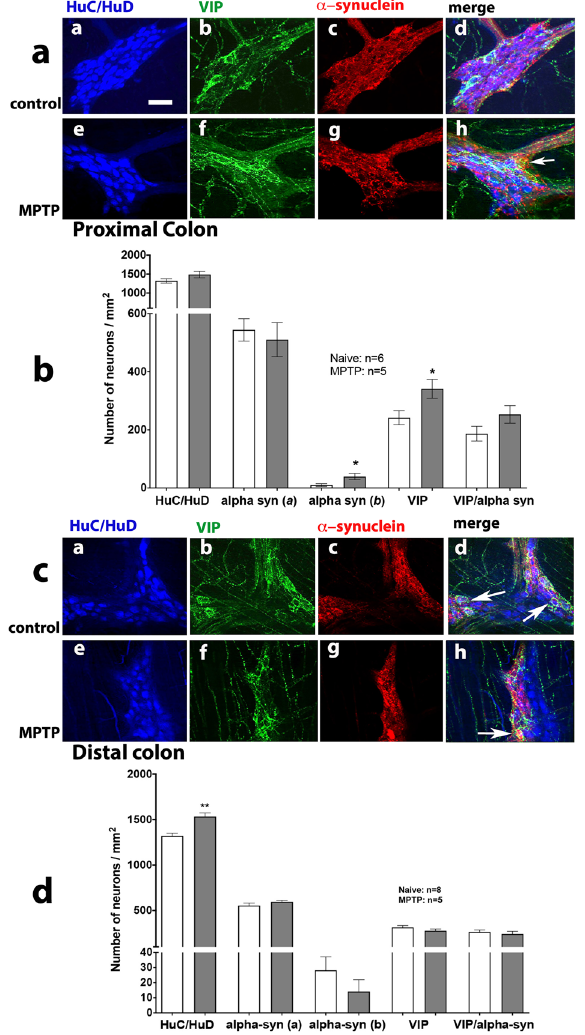
Fig. 7 Effect of MPTP treatment on the number of HuC/D-, VIP- and α -synuclein-ir in the proximal and distal colon of naïve control and MPTP-treated common marmosets. Inset panels ( a , e ) show HuC/D-ir; ( b , f ) show VIP-ir and ( c , g ) show α -synuclein-ir in the proximal ( a ) and distal ( c ) colon of naïve control and MPTP-treated common marmosets. Panels ( d, h ) show triple immuno fl uorescence for HuC/HuD- (blue), VIP- (green) and α -synuclein-ir (red) in the myenteric plexus from proximal (main panel a ) and distal (main panel c ) colon of na ϊ ve and MPTP-treated animals. Quantitative analysis of VIP-ir and α -synuclein-ir ( a : soma; b : extracellular surrounds) neurons in MPTP-treated marmosets compared to na ϊ ve controls in the proximal and distal colon is shown in the main panels ( b ) and ( d ), respectively. The number of immunoreactive neurons are expressed as mean ± SEM. * P < 0.05 compared to naïve control (Students t -test). White arrows indicate co-localisation of VIP- and α -synuclein-ir. The scale bar in panel ( aa ) indicates 100